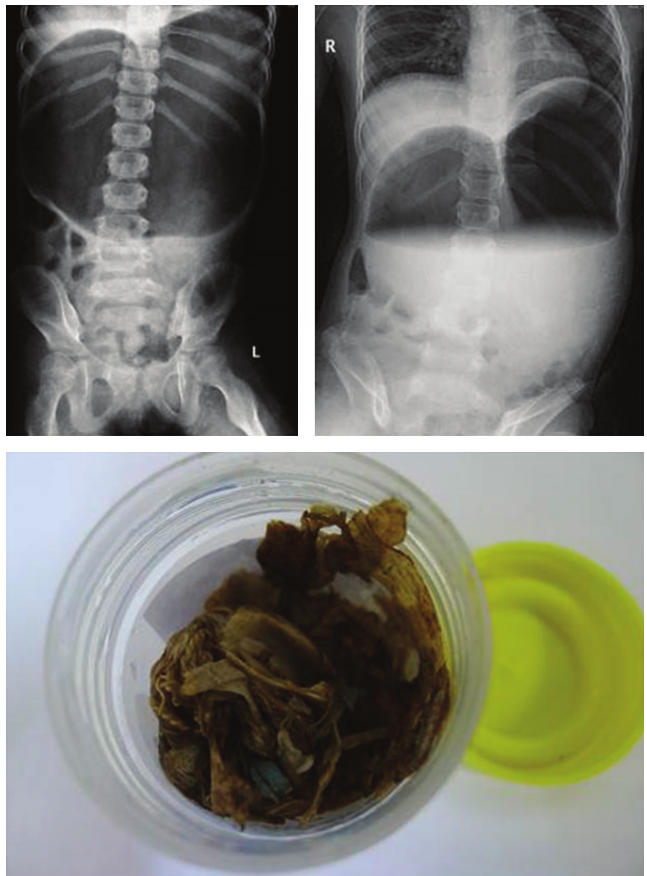
Figure 1: Grossly distended stomach by radiography and debris (gauze and adhesive tape) removed in this child with 46XX del